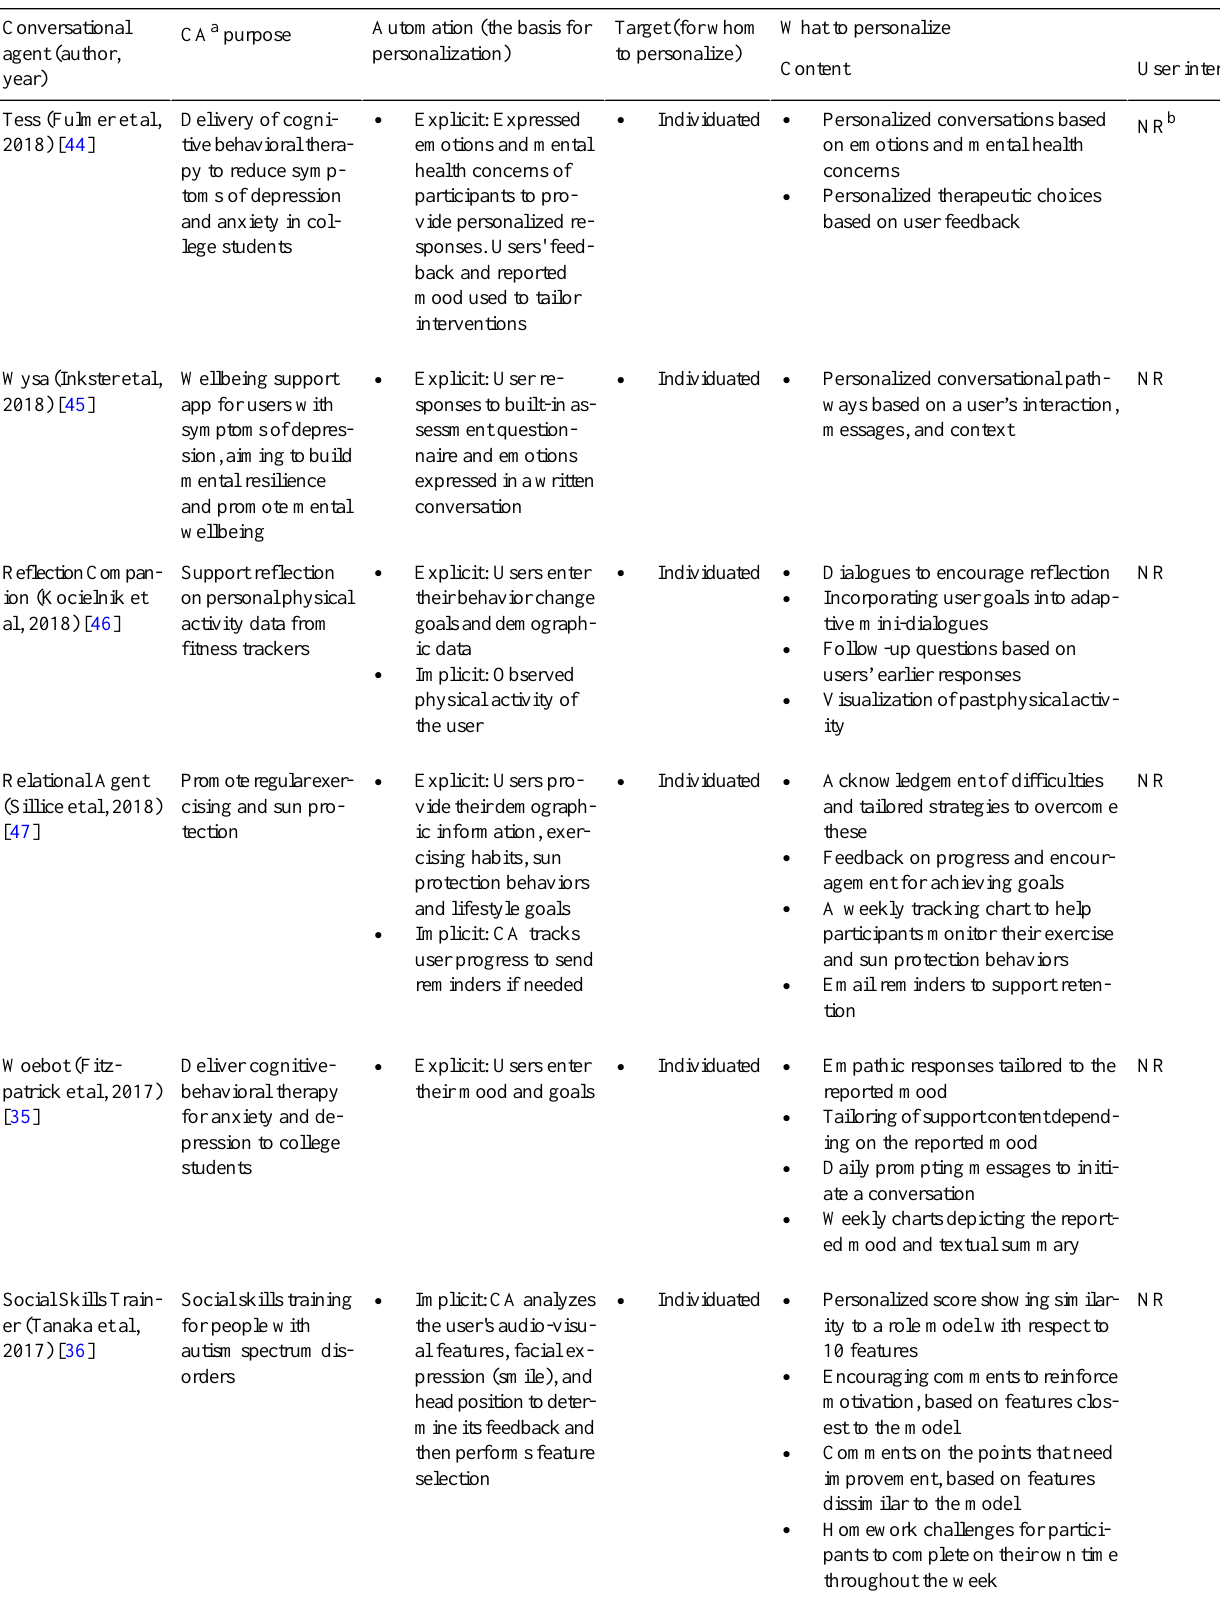
Table 2. Personalization features of conversational agents in the included studies.